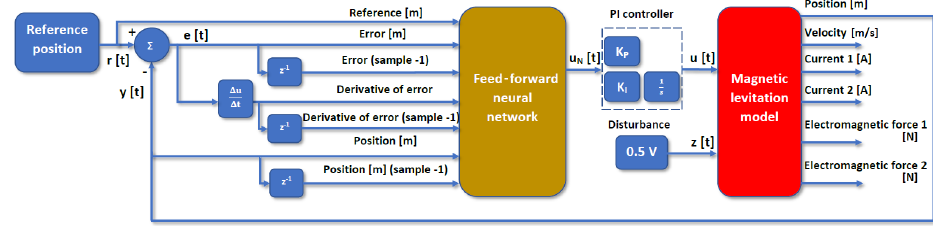
Figure 9. The structure of the neural network control